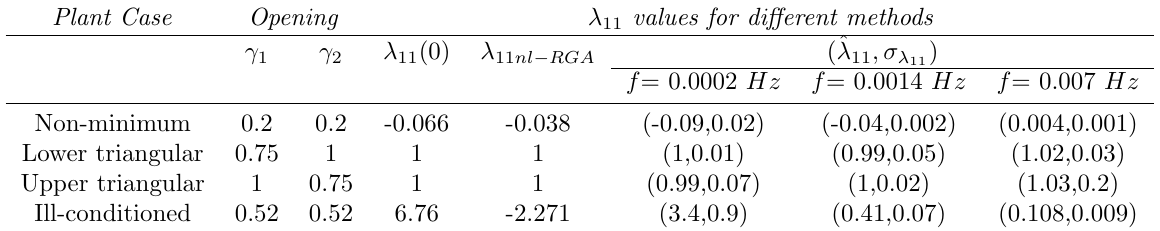
Table 3: Pairing suggestions of different plant cases based on different methods Plant Case